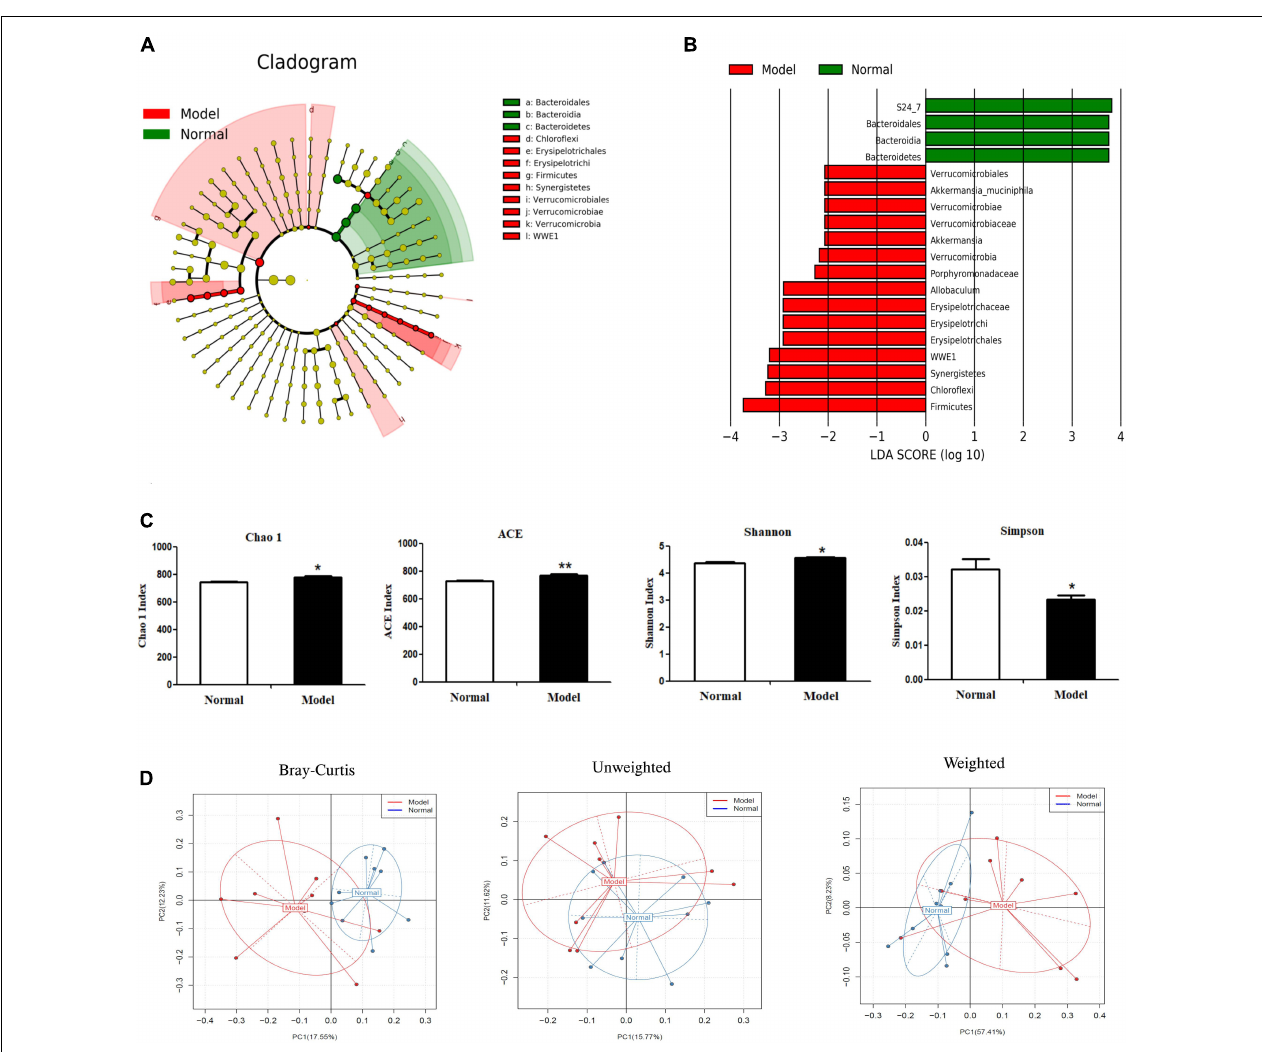
FIGURE 3 | Microbial composition analysis by 16S rRNA gene sequencing. (A) Cladograms displaying the taxa with significantly different abundance. Model vs. Normal group. Only the taxa with absolute log 10 LDA scores > 2.0 are displayed. (B) Selected microbial taxa significantly impacted in PD mice. Only those taxa with the absolute log 10 LDA scores > 2.0 are listed in the charts. (C) α -diversity as indicated by microbial diversity indices of Chao1, ACE, Shannon, Simpson. (D) β -diversity analysis: Principal coordinates analysis (PCoA) derived from Bray-Curtis distances, unweighted and weighted UniFrac among samples of two groups (Model vs. Normal ). * p < 0.05, ** p < 0.01 vs. Model